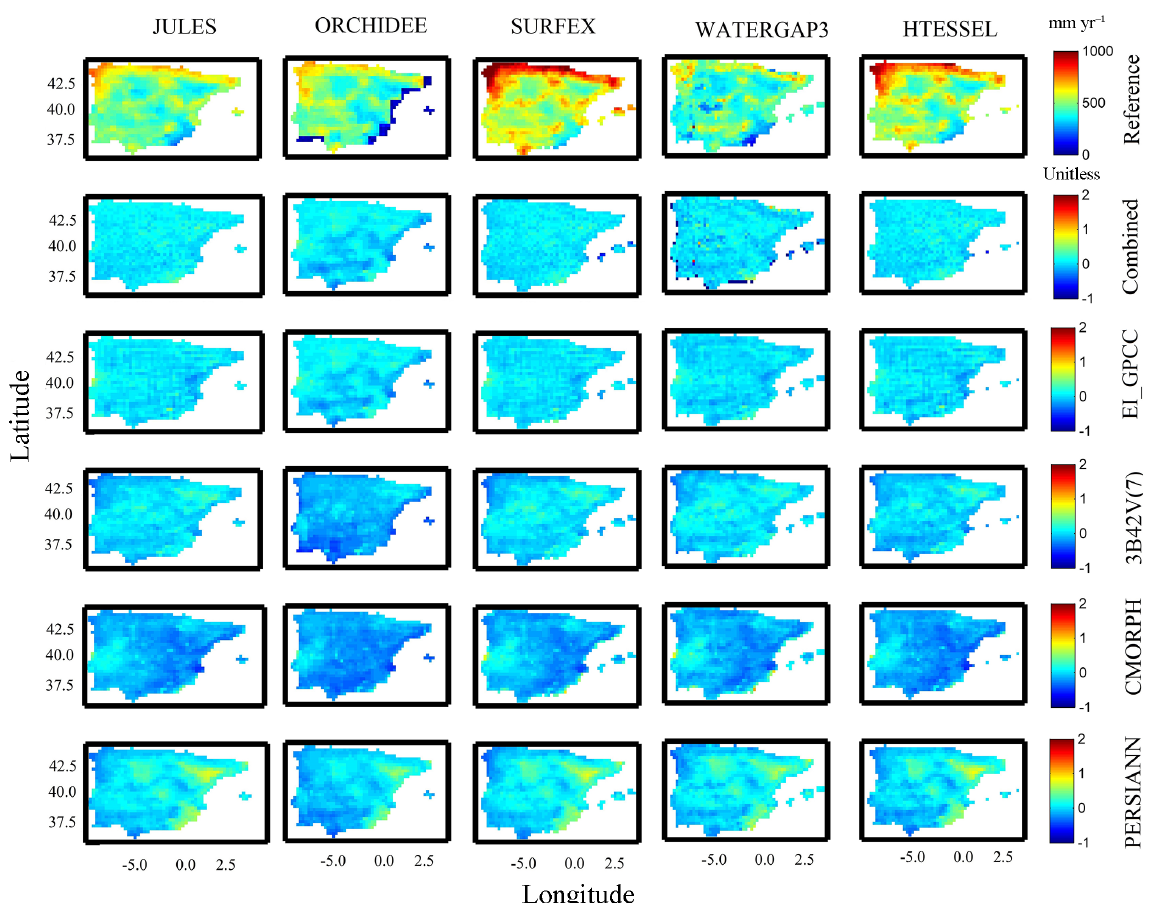
Figure 5. Map of SAFRAN-based simulations (Reference) of evapotranspiration (top row), and relative difference for the various models (columns) and precipitation forcing (rows 2–5) analyzed.